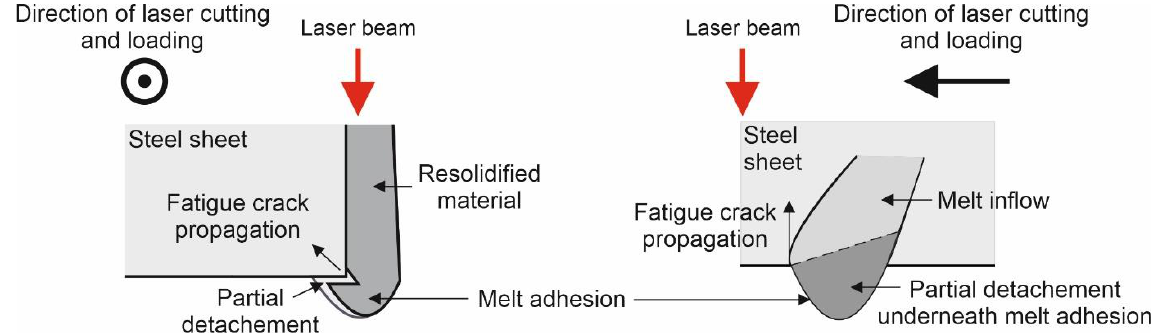
Figure 11. Schematic drawing for partial detachment of melt adhesions on strongly deformed laser-cut edges.